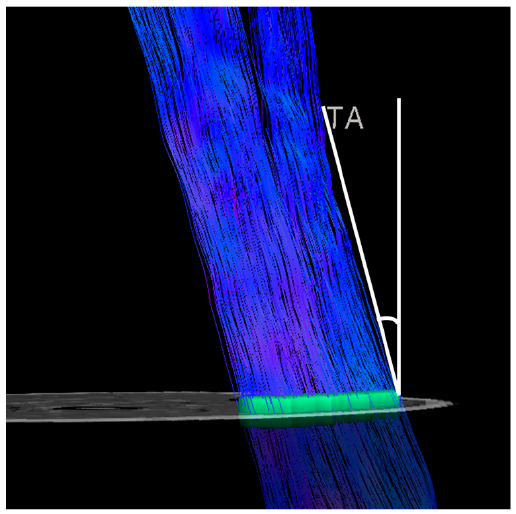
Figure 3. Calculation of the pennation angle for the TA